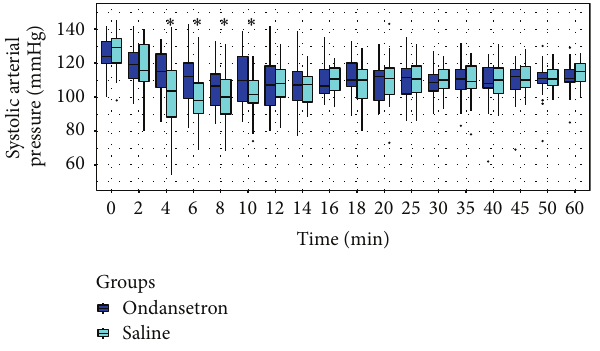
Figure 2: Trends of systolic blood pressure (SAP). ∗ < 0.05 .